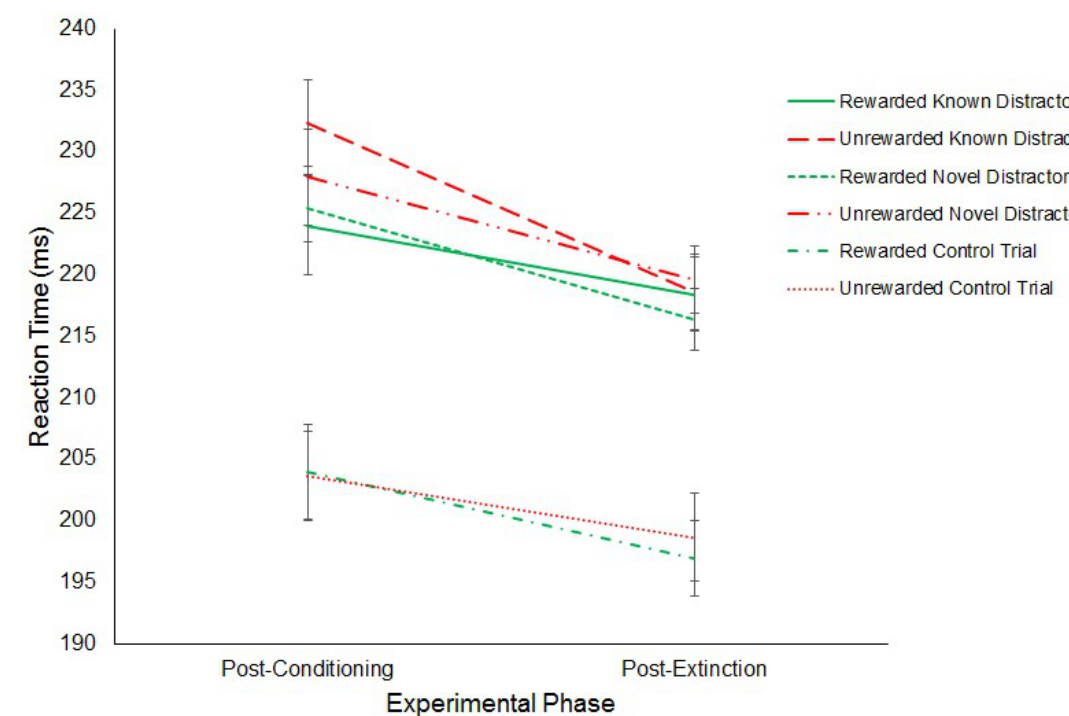
Figure 7. Latency of rewarded and unrewarded distractor trials across the post-conditioning and post- extinction phases of the remote distractor task in Experiment 1. Error bars show +/−1